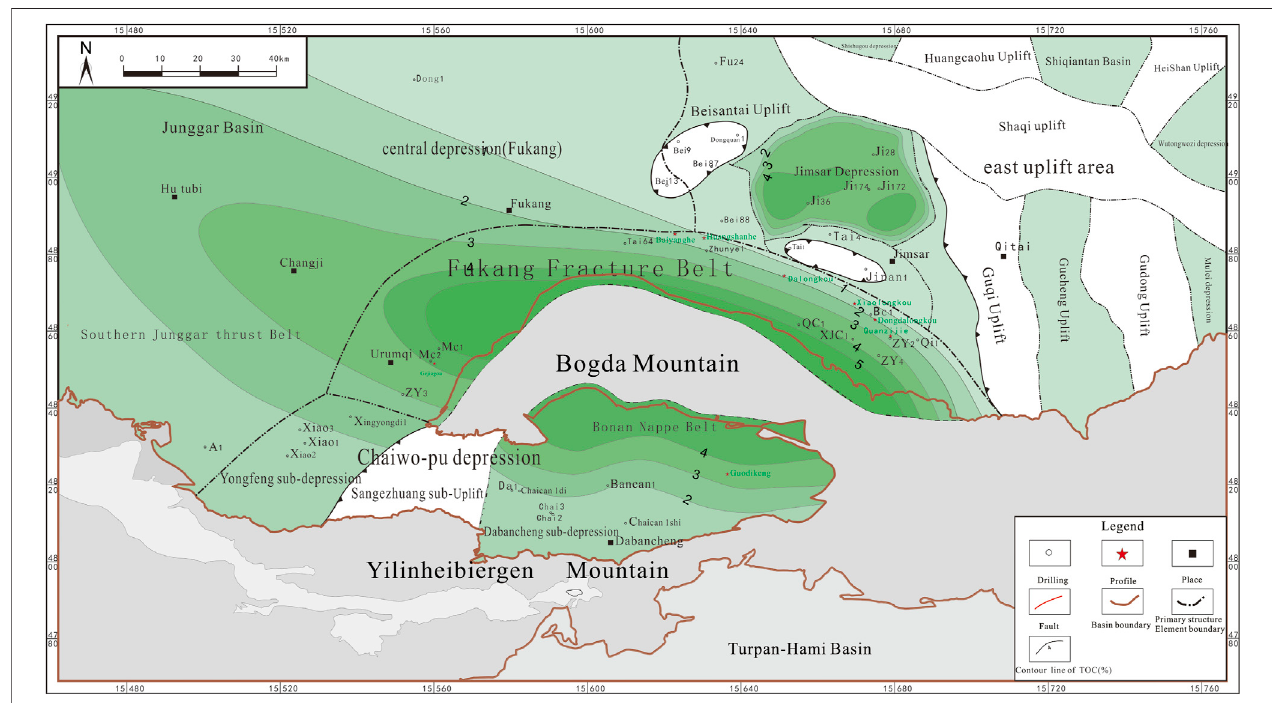
FIGURE 3 | Contour map of organic carbon content in the source rocks of Lucaogou Formation.